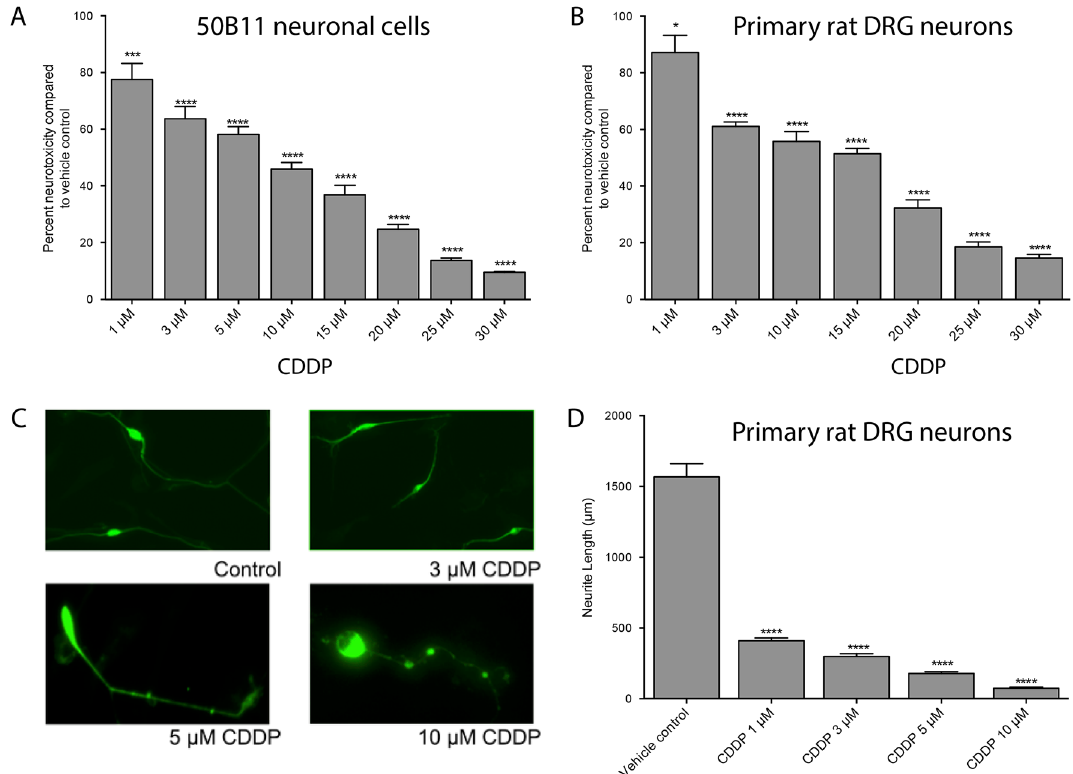
Figure 1. Cisplatin caused a dose dependent toxicity on rat immortalized DRG neuronal cell line ( A ) and primary rat DRG neurons ( B ) as assessed by ATP measurements. Exposure of primary rat DRG neurons also caused a dose-dependent degeneration of neurites ( C , D ). Panel C shows degeneration and blebbing in representative images of fixed and stained DRG neurons. (n = 3/condition, one-way ANOVA, * p < 0.05, *** p < 0.0005, **** p < 0.0001, error bars denote